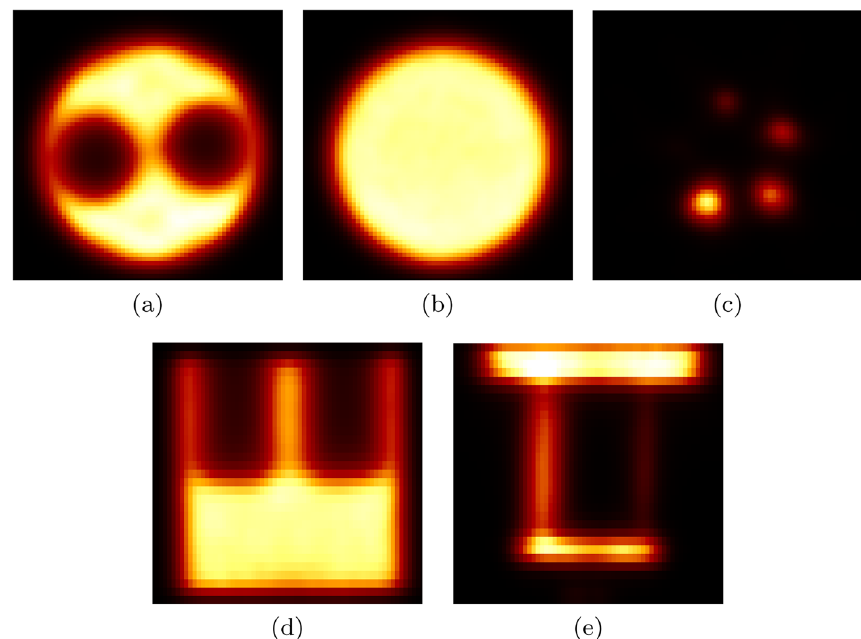
Fig. 5 Different cross sections of the NEMA image quality phantom reconstructed using MLEM with 30 iterations, including random, scatter, attenuation and normalization corrections into the reconstruction. a Transverse view of cold rods, ( b ) transverse view of the uniform region, ( c ) transverse view of hot rods, ( d ) coronal view of cold rods and uniform region and ( e ) sagittal view of hot rods